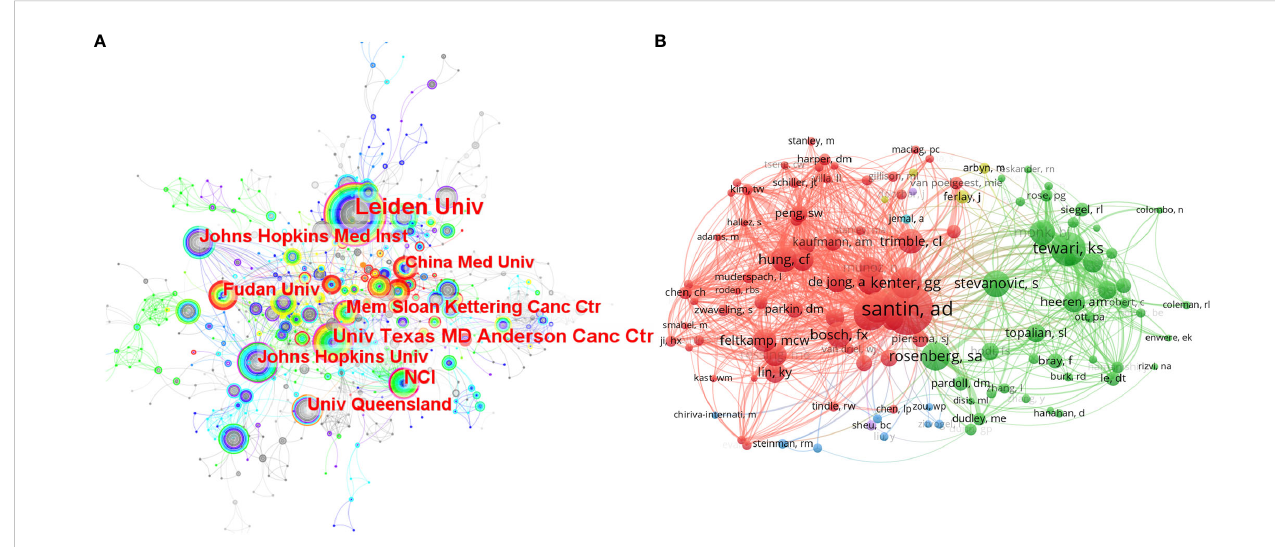
FIGURE 2 (A) The co-occurrence map of the researching institutions. The size of a node lies on the publication number of an institution. The width of the purple circle around a node represents the betweenness centrality of an institution. (B) The network map of researching authors who were co-cited over 40